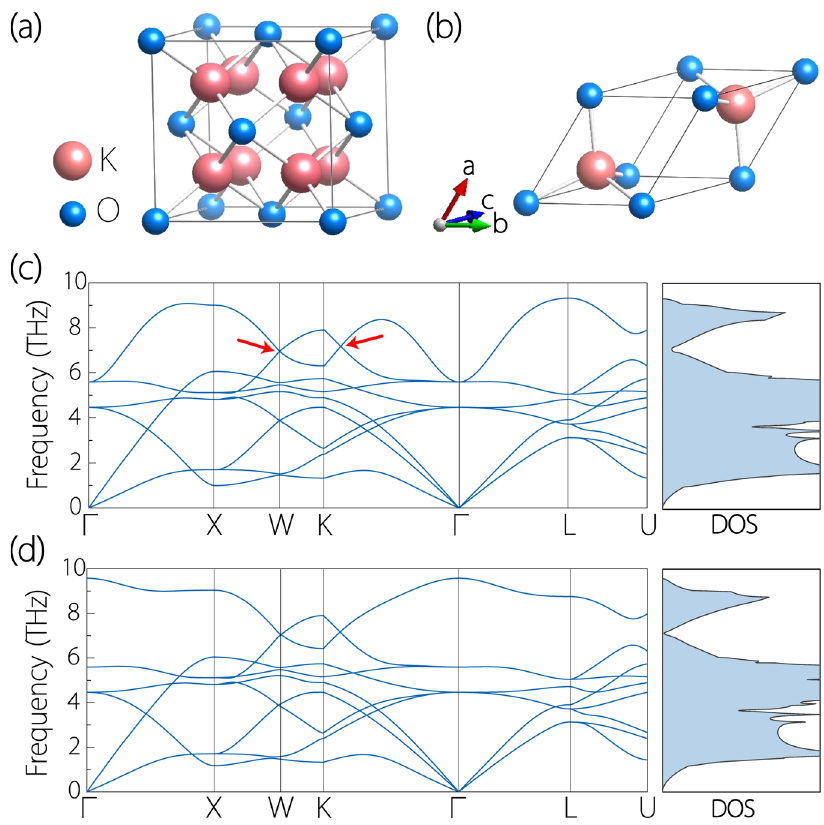
Fig. 3 Calculated phonon spectrum and phonon density of states for K 2 O. a Conventional unit cell and ( b ) primitive cell of K 2 O. c Calculated phonon spectrum and phonon density of states for K 2 O. The arrows indicate points on the nodal chain. d Calculated phonon spectrum and phonon density of states with non-analytic correction (LO-TO splitting)